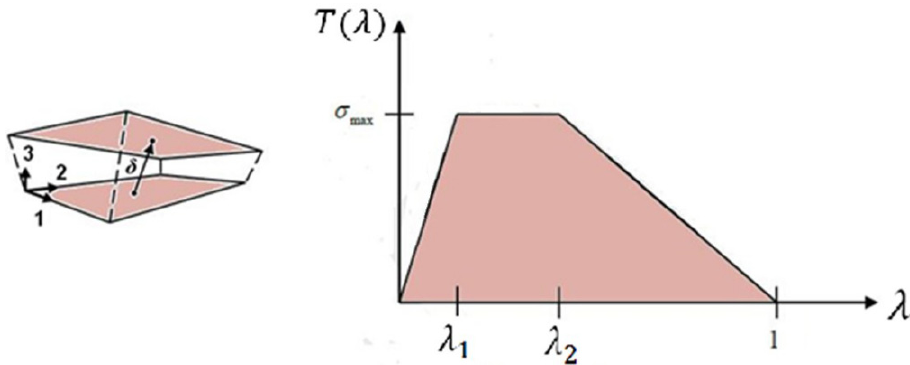
Figure 3. Trilinear traction-separation law for material type MAT185